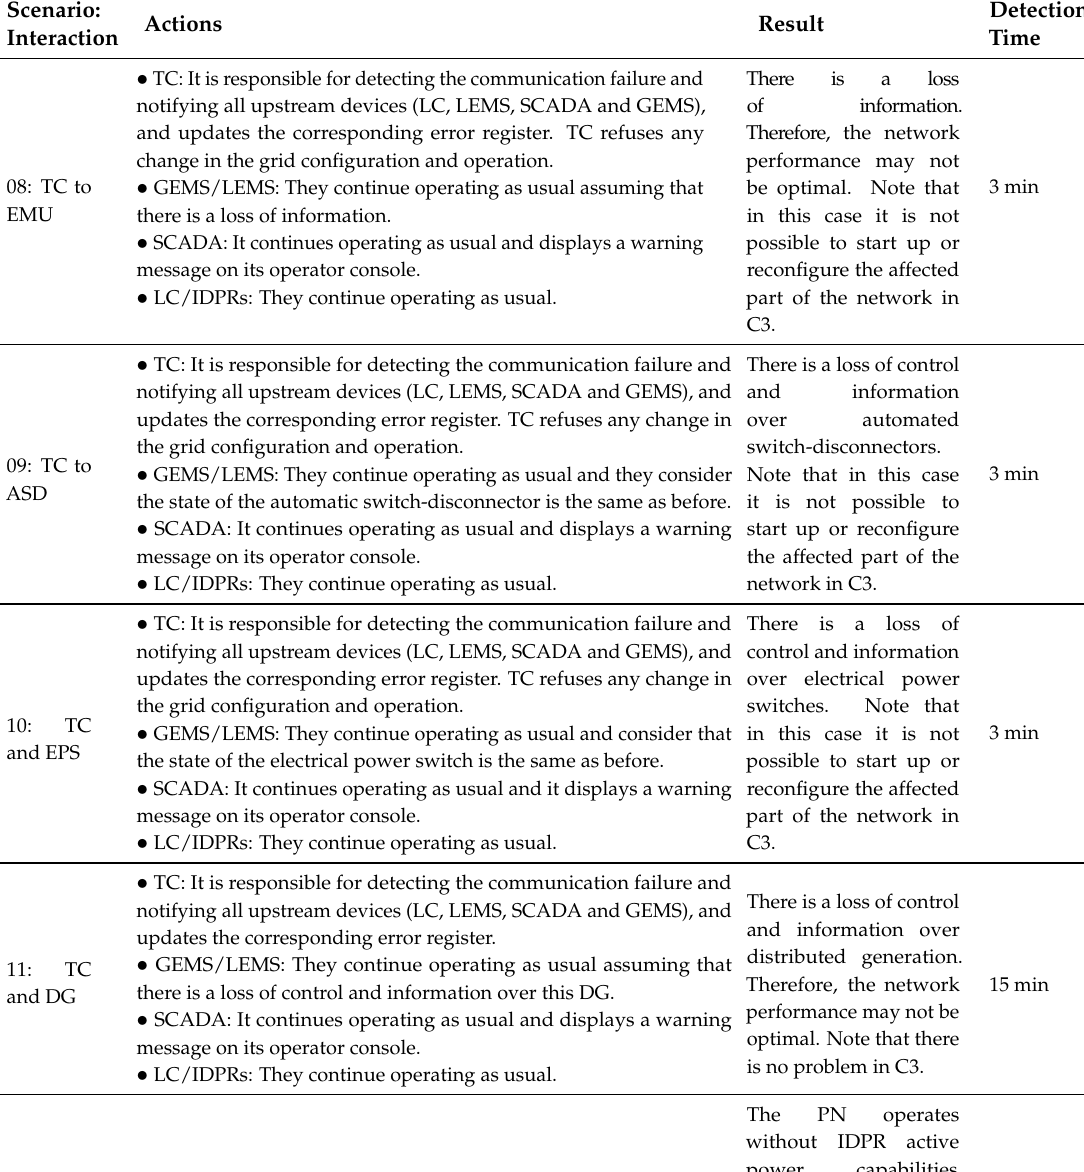
Table 7. Actions in function of the operational circumstances 1, 2, and 3. Part